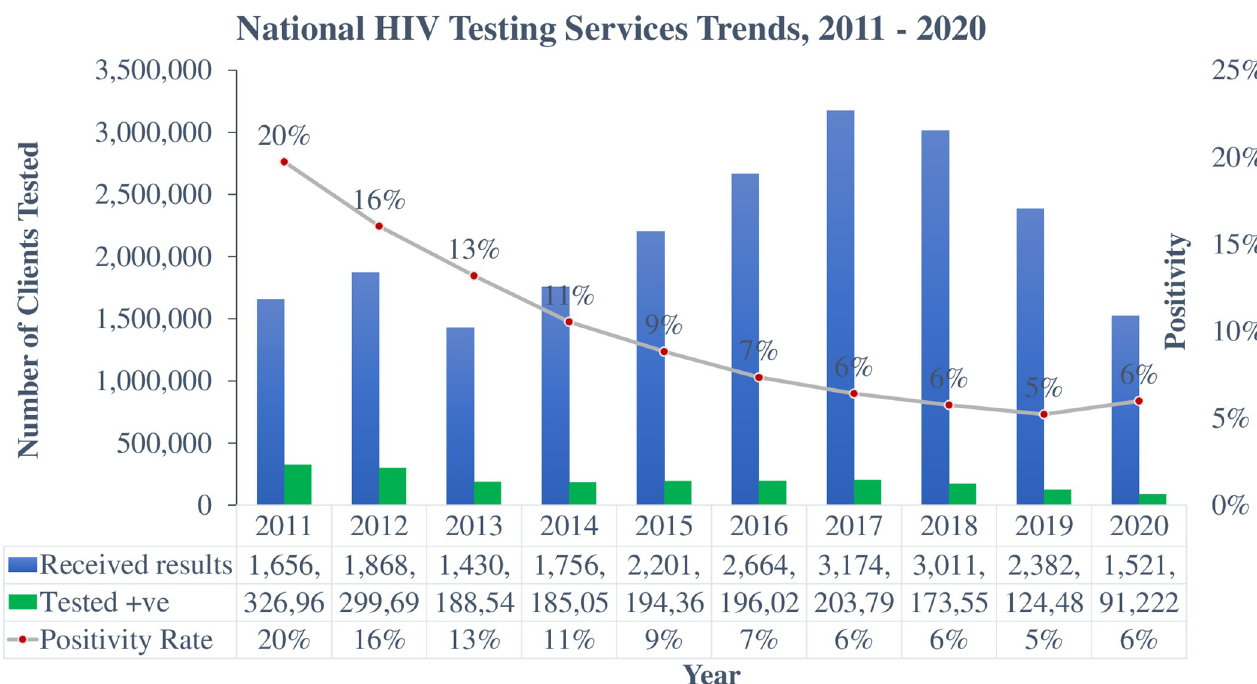
Fig 1. Zimbabwe national HIV testing services trends, 2011–2020 (source: HIV prevention annual program performance report, 2020).